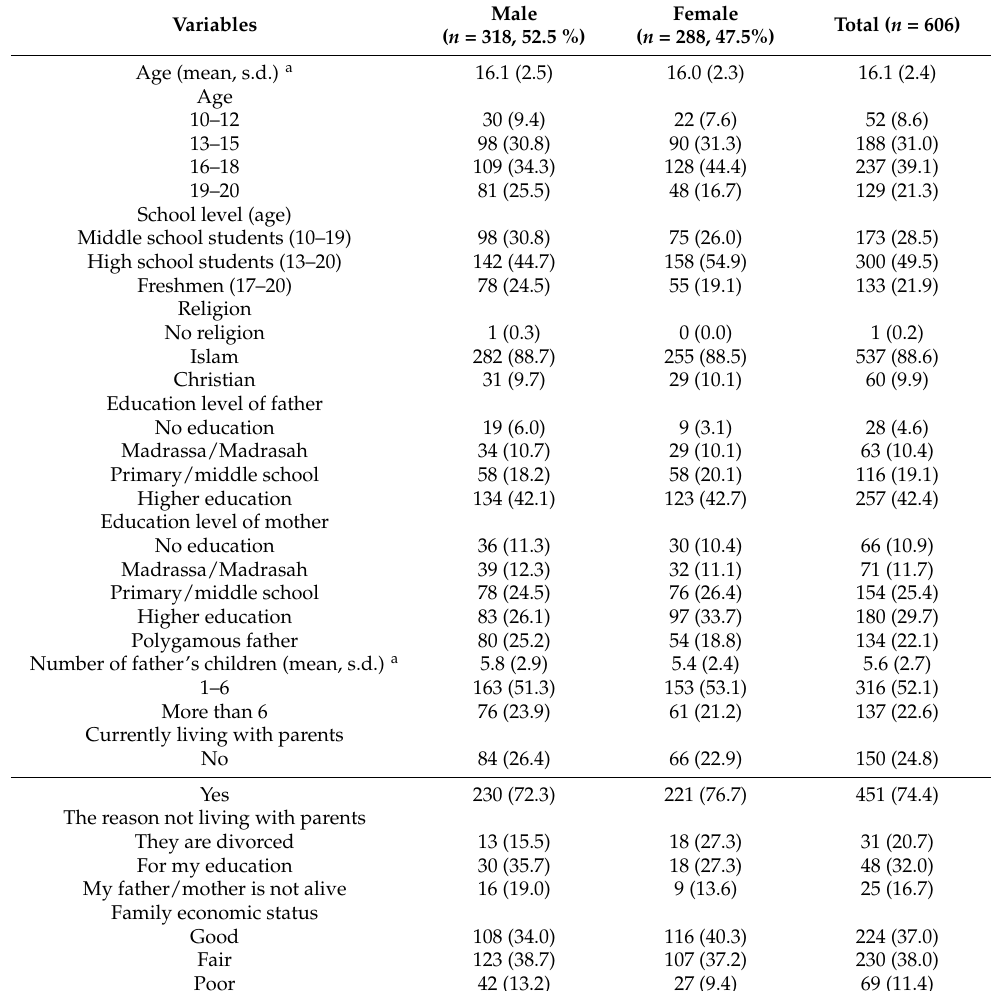
Table 1. Sociodemographic characteristics of participants by